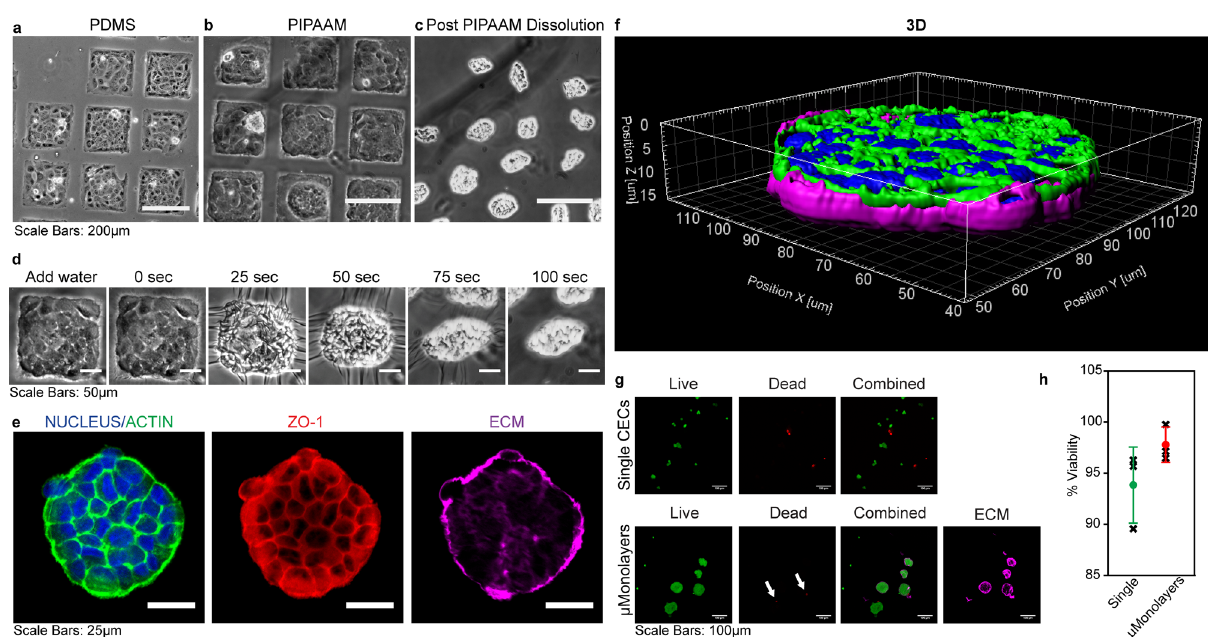
Fig. 2 Bovine CE cells form μ Monolayers on ECM squares and maintain their structure and viability through shrink-wrapping and injection. a CE cells form monolayers on ECM squares microcontact printed onto PDMS (used as a control) and b on the thermoresponsive polymer PIPAAm. c Once the PIPAAm is dissolved the CE cell μ Monolayers contract and are shrink-wrapped in the ECM squares. d The release and shrink-wrapping of μ Monolayers occurs quickly, in <100 seconds once the water + sample cools to room temperature. e Confocal microscopy images show that after injection, the CE cells maintain both their cytoskeletal structure (F-actin, green), tight junctions (ZO-1, red), and adherence to the ECM scaffold (LAM + COL4, purple). f A 3D render of a shrink-wrapped CE cell μ Monolayer 30 minutes after injection onto a glass surface illustrating how it begins to relax and return to its original shape. g Representative live/dead images of control single CE cells and shrink-wrapped CE cells show that both types of cells are viable with very few dead cells present. h Live/dead data showed no signi fi cant difference in viability between single cells (93 ± 4 %) and shrink-wrapped cells (97 ± 2%) following injection through a 28 G needle ( n = 3 biologically independent samples for each; mean ± stdev represented by the dots and bars, individual samples are shown as the black x ’ s; N.S. by Student ’ s t test Single vs. μ